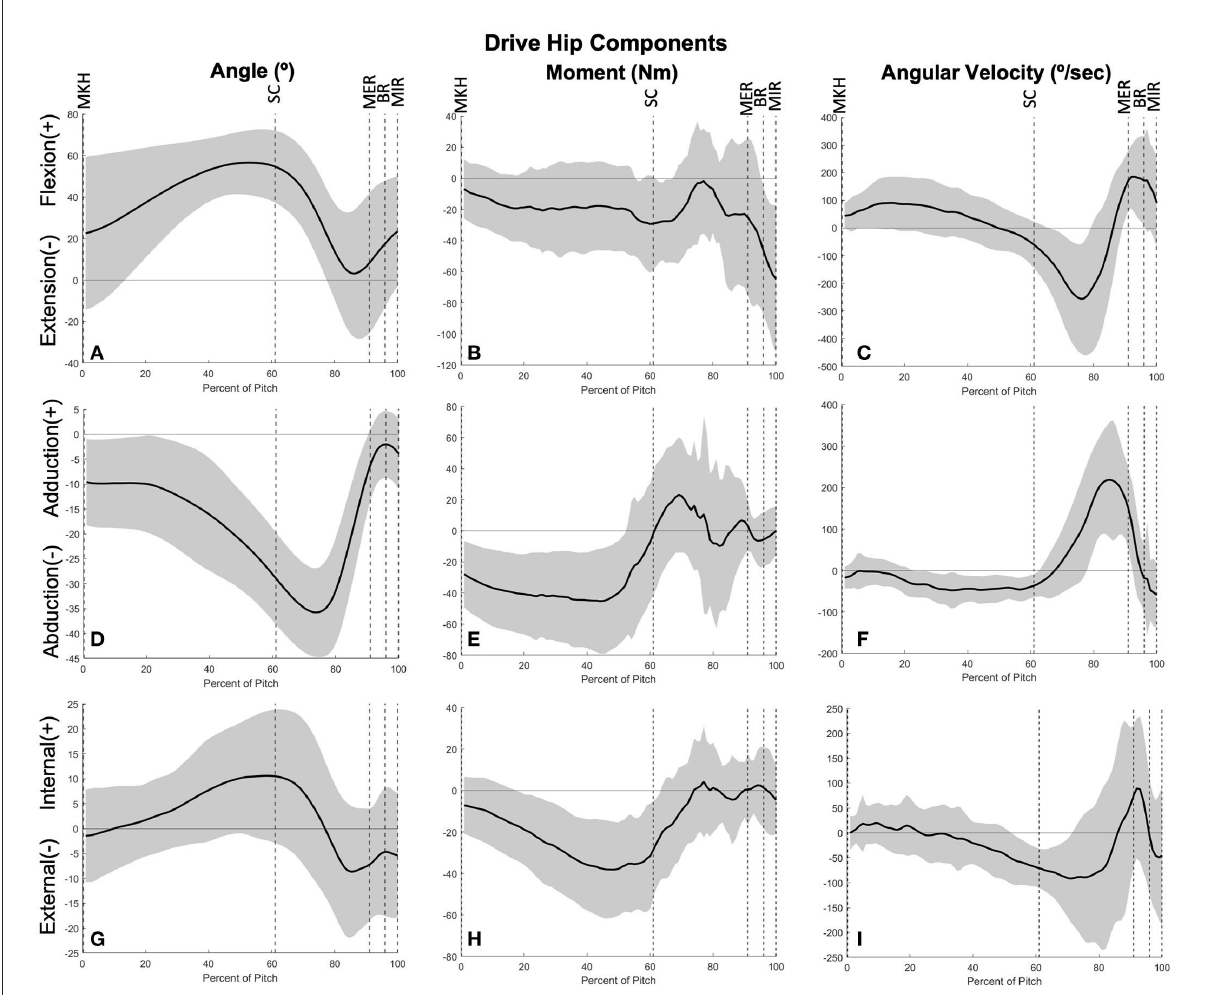
FIGURE5 Mean ± SD joint angle, joint moment, and joint angular velocity for the drive hip in extension/flexion (A–C) , ab/adduction (D–F) , and internal/external rotation (G–I) for the duration of the pitch from maximum knee height (MKH) to maximum internal rotation